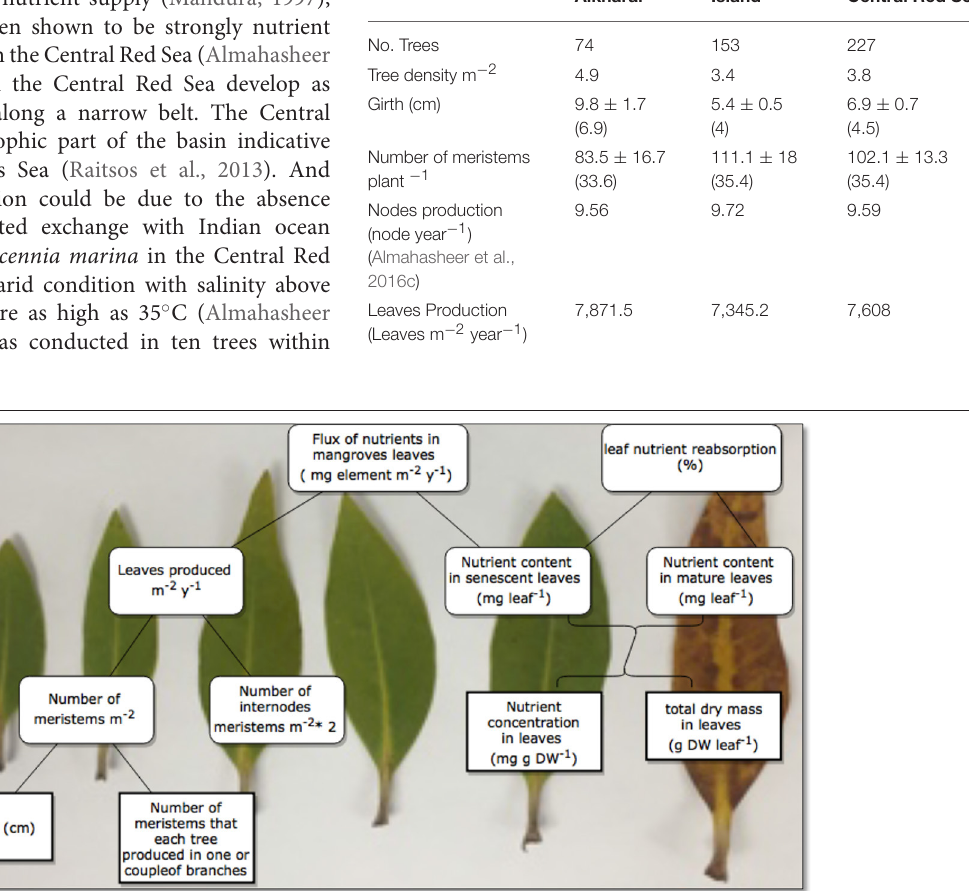
Frontiers in Marine Science |